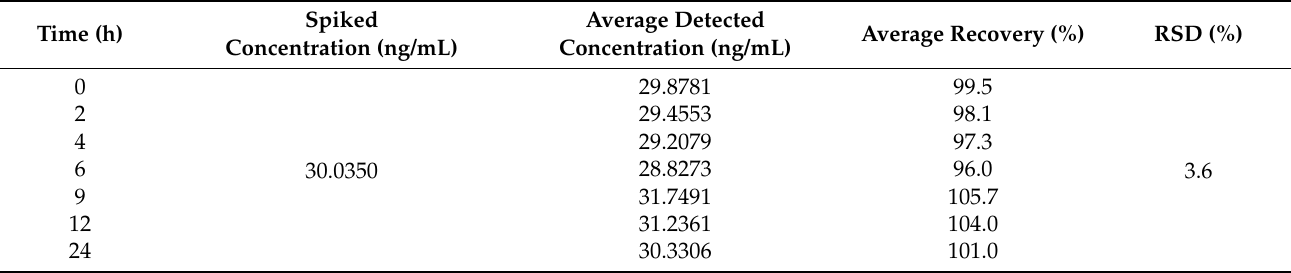
Table 6. Stability results of the proposed